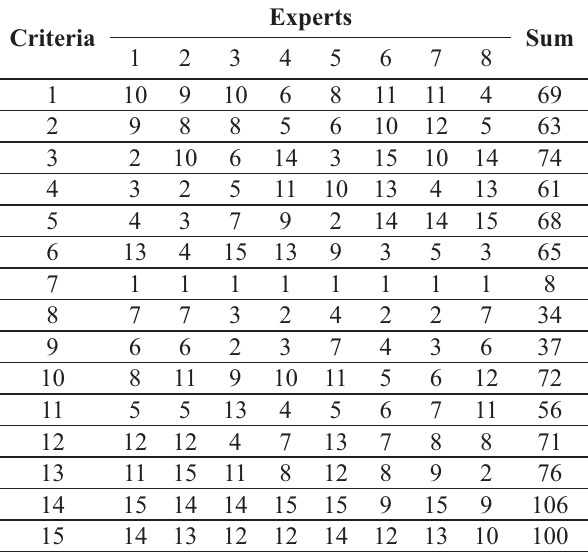
Table 5 . Ranking of Group 2 criteria